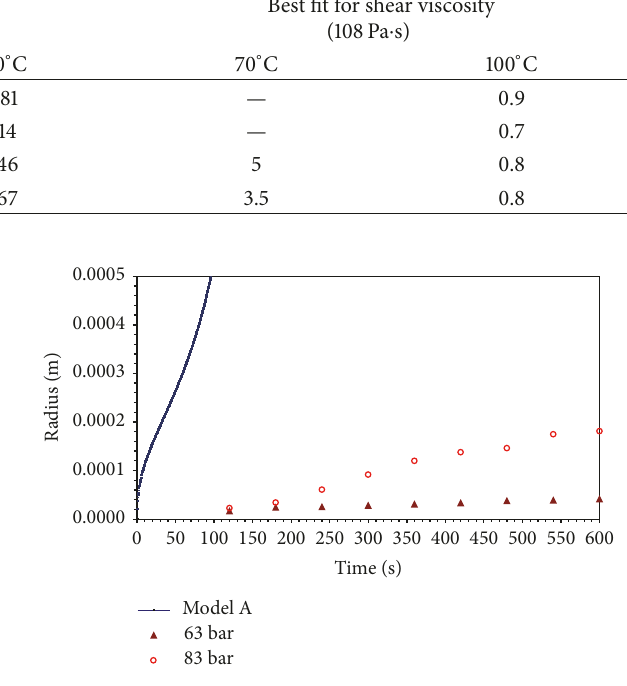
Figure 15: Model A versus experimental data for bubble growth at 70 ∘